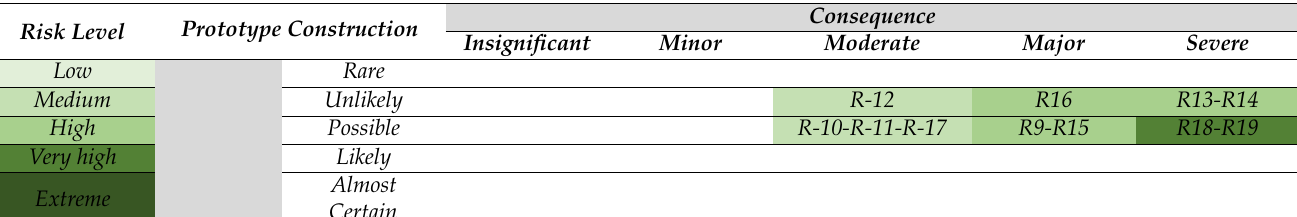
Table 4. Evaluation of main risks affecting the CSP–CaL prototype